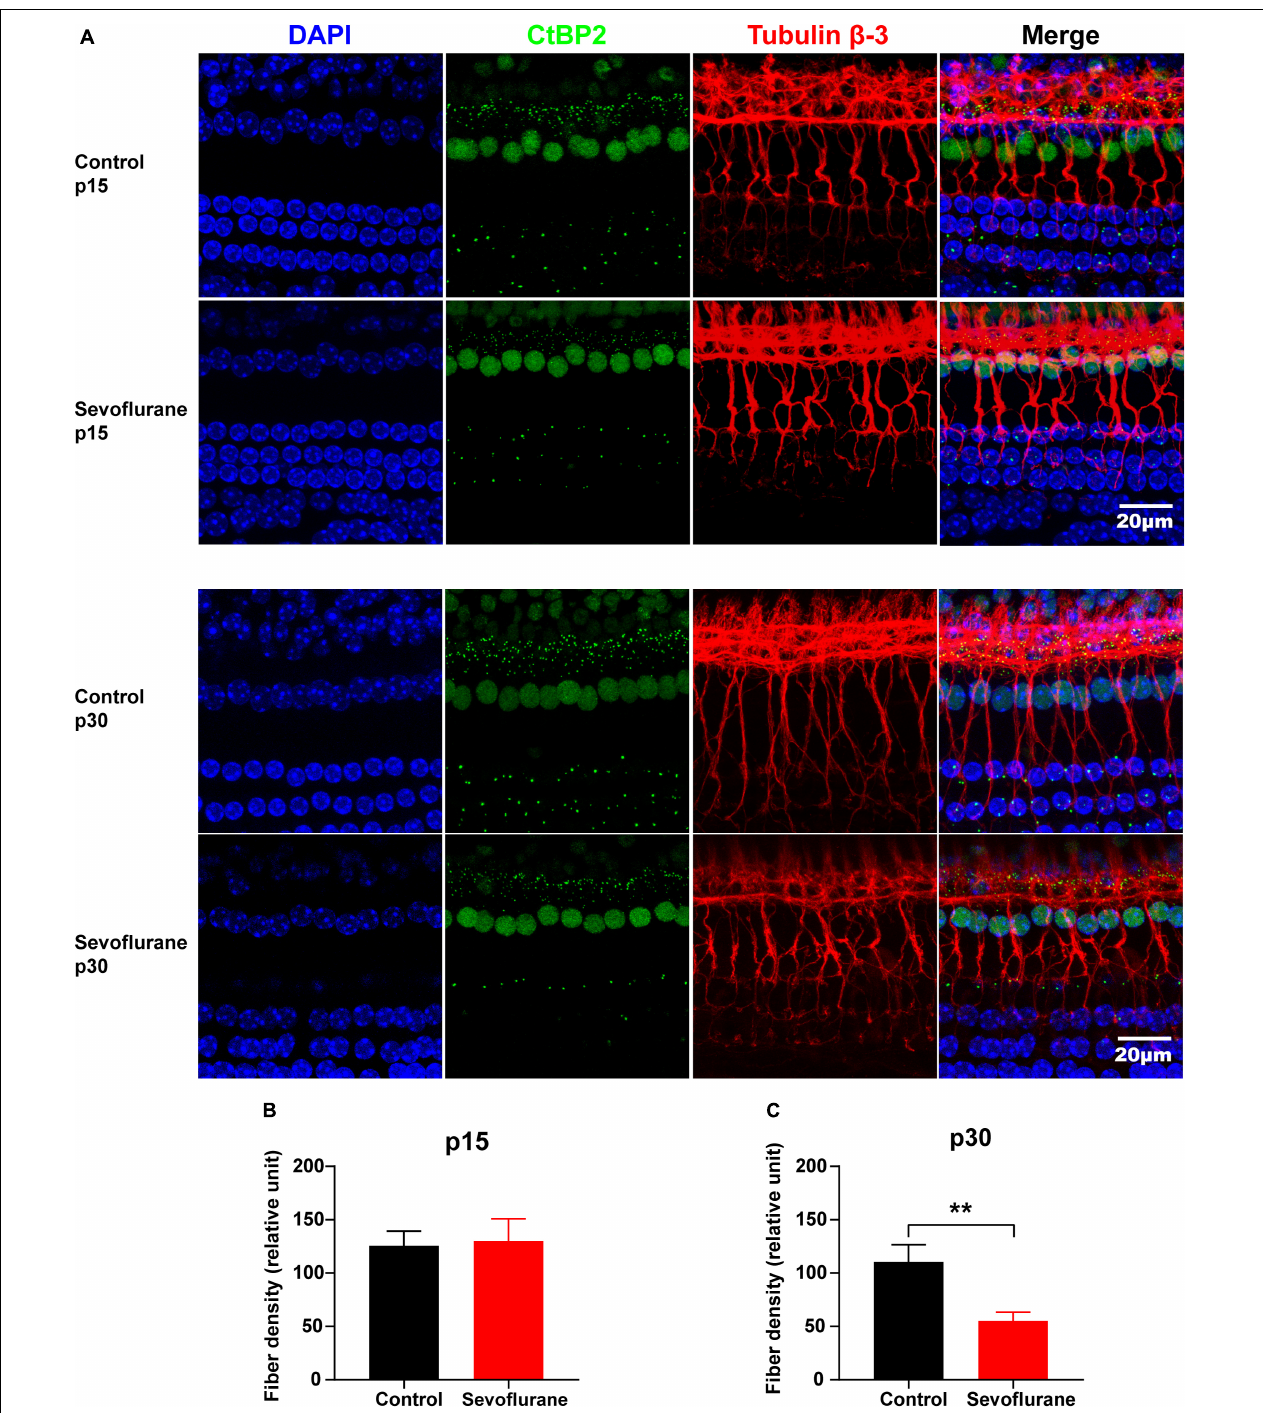
FIGURE 4 | Multiple sevoflurane exposures in naïve mice lead to degeneration of spiral ganglion neuron (SGN) nerve fibers. (A) Pre-synaptic ribbons and nerve fibers labeled using CtBP2 (green) and tubulin β -3 (red), respectively. Nuclei are labeled with DAPI (blue). (B,C) The SGN peripheral fibers density on P15 (B) and P30 (C) . The density of SGN peripheral fibers is comparable in the two groups on P15. In contrast, on P30, it decreased significantly in the sevoflurane group than that in the control group ( n = 7 control group, n = 8 sevoflurane group). ** P < 0.01, unpaired Student’s t -test. Scale bar = 20 µ m.